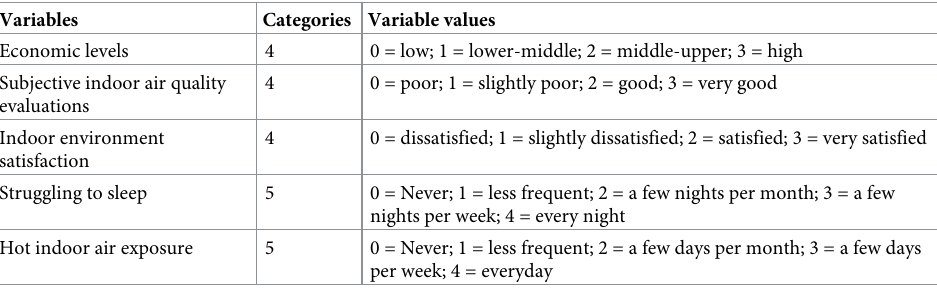
Table 6. Independent variables for structural equation